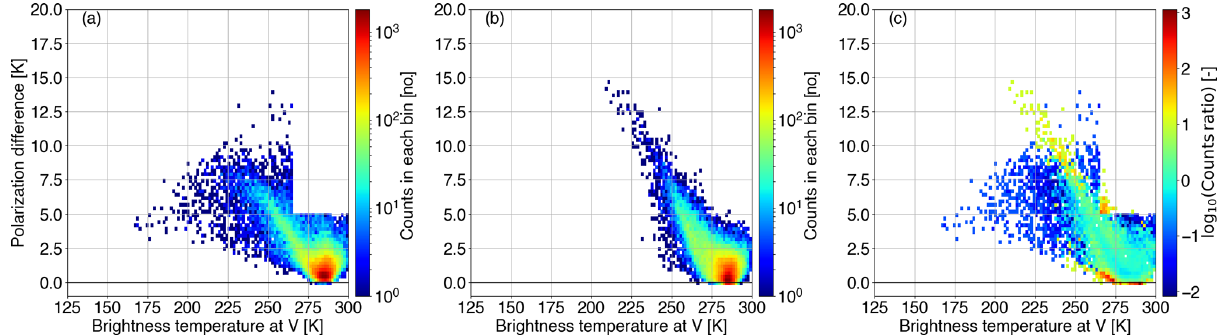
Figure B1. Two-dimensional (2D) histograms describing the arch-like relationship between the polarization difference and the brightness temperature at V polarization at 89.0GHz as (a) observed (PD o – T o (c) the 2D histogram divergence between (PD o – T o the simulated 2D bins are